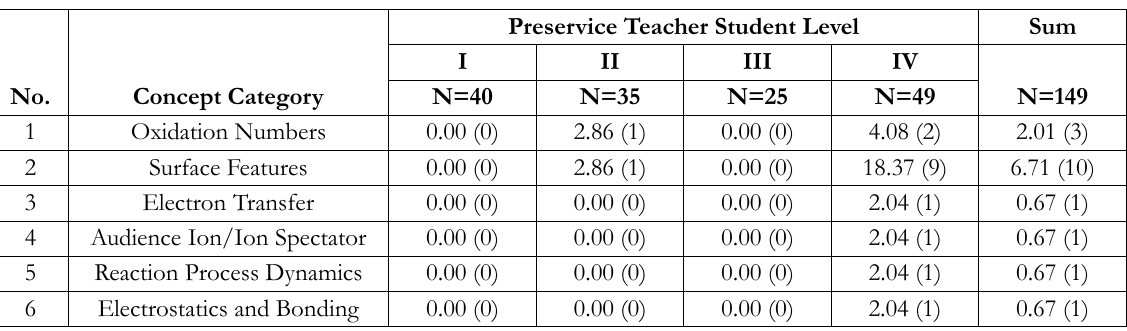
Table 6. Percentage Consistency of Preservice Chemistry Teachers’ Answers in Six Concept